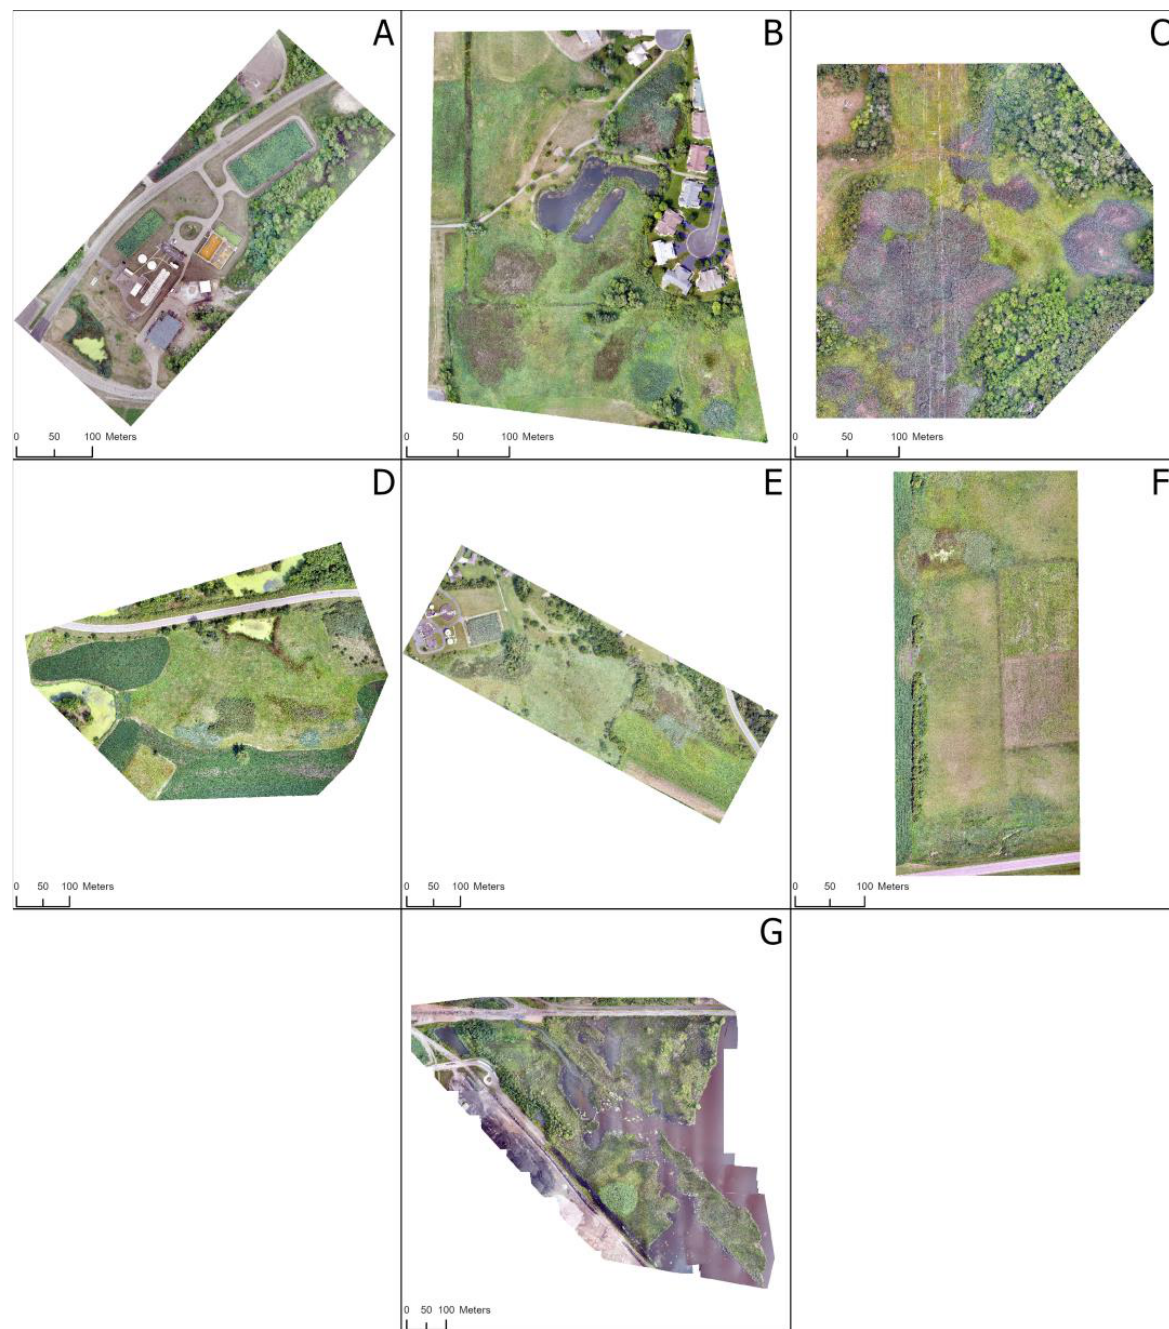
Figure 2. Study sites: ( A ) Delano wastewater treatment facility, ( B ) Delano City Park, ( C ) Chisago City, ( D ) Wabasha, ( E ) Chatfield wastewater treatment facility, ( F ) Swan Lake Wildlife Management Area, and ( G ) Grassy Point Park.